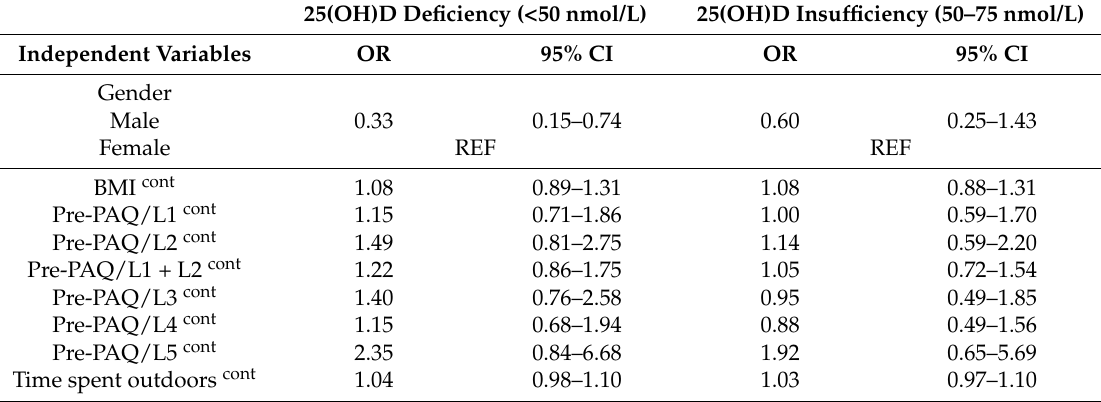
Table 3. Correlates of the 25(OH)D level in the total sample ( n = 260). 25(OH)D sufficiency (>75 nmol/L) was used as the reference value.